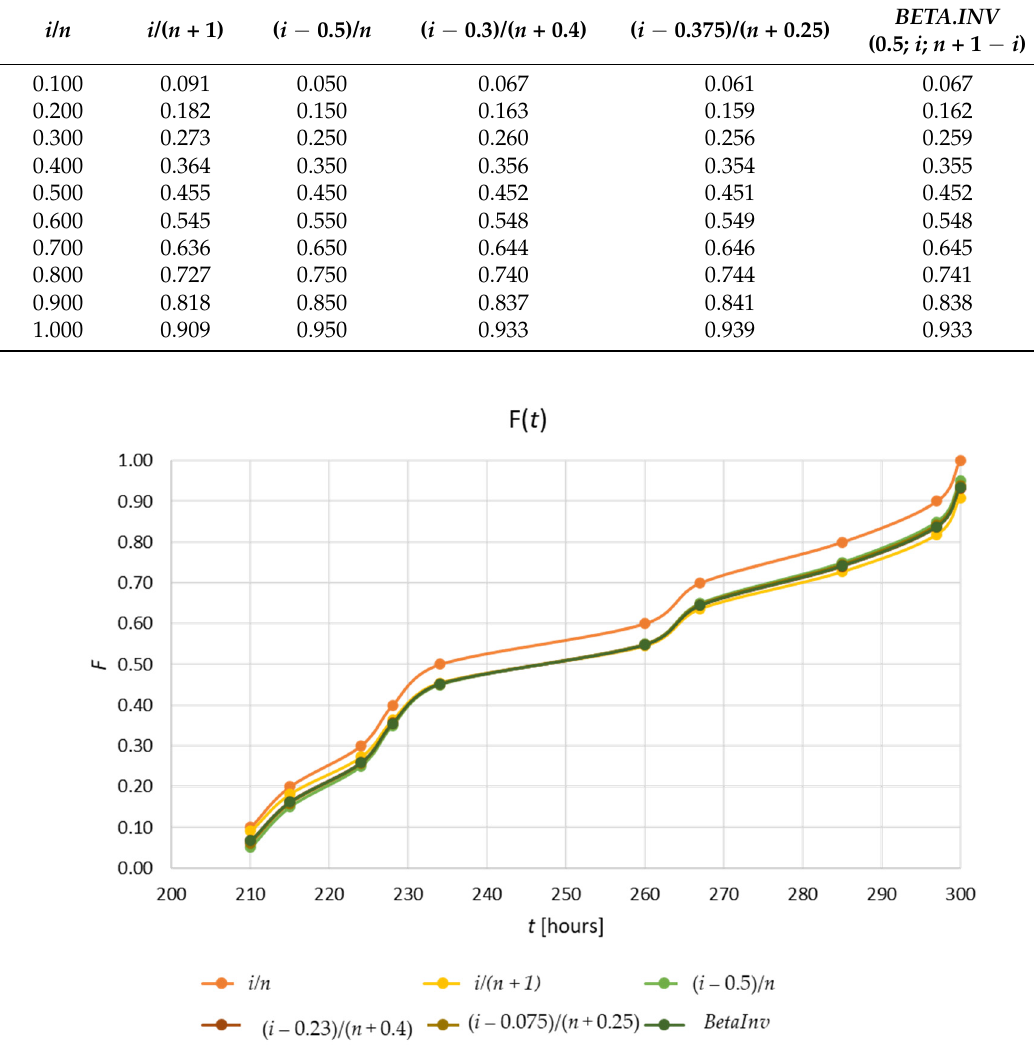
Table 1. Distribution function estimator values F ( t ) .